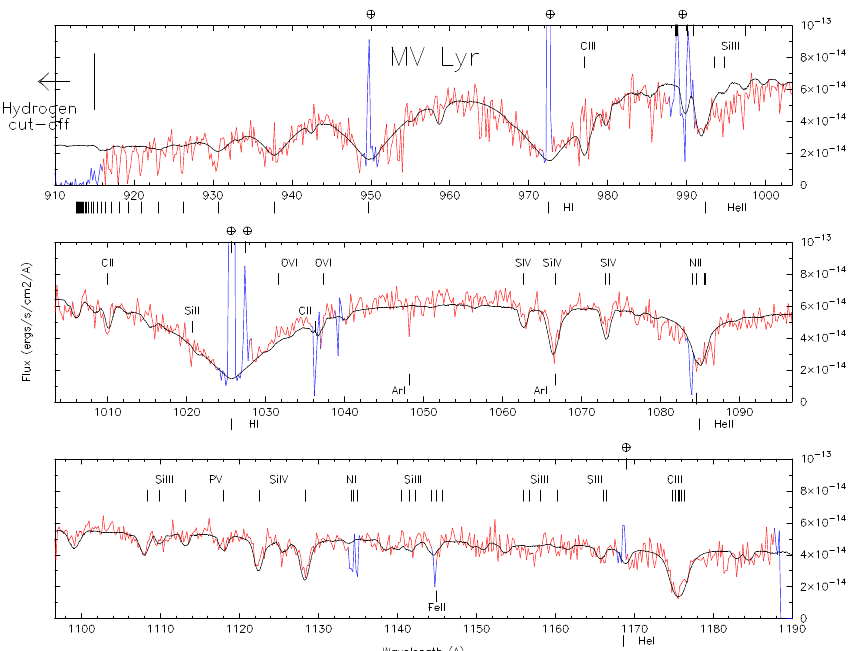
Figure 5. The FUSE spectrum of MV Lyr (in red) obtained in a low state is fitted with a WD stellar model (in black). The model has a temperature of T eff = 44,500 ± 500 K, Log(g) = 8.23 ± 0.02. The sharp emission lines are geocoronal in origin and are marked with plus sign inside a circle above the panels. There are also some ISM absorption lines from C II , Fe II , Ar I , and N II ; all these have been colored in blue and are not modeled. There are some faint emission features from C II (977), and from the O VI doublet ( ∼ 1032 & ∼ 1038). The remaining absorption lines are all stellar and are marked, and all are well fitted with solar abundances and with a projected rotational velocity V rot sin ( i ) = 200 ± 50 km/s. The hydrogen orders of the Lyman series are marked under the panels for clarity. With a Gaia distance of 499 + 13 − pc, and using the C/O-core WD mass–radius relations 11 from [32], we obtain a white dwarf mass of 0.78 ± 0.01 M (cid:12)